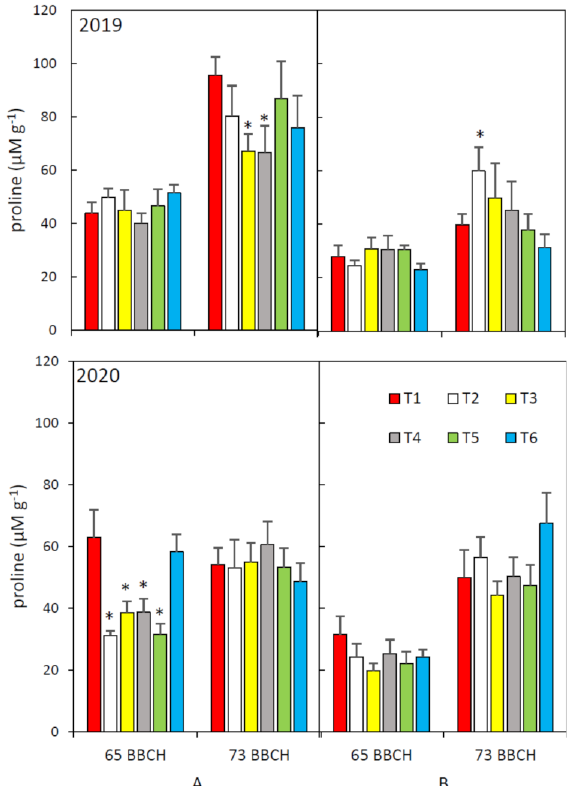
Figure 4. Proline content in the cultivar with blue aleurone KM-72-18 ( A ) and a multi-row spike KM-94-18 ( B ) in the development phases 65 and 73 BBCH at single treatments of the stand (T1–T6). Means ± SE; n = 5; LSD post hoc test. For each period and cultivars, the columns with the symbol * are significantly different at p < 0.05 compared to the control treatment